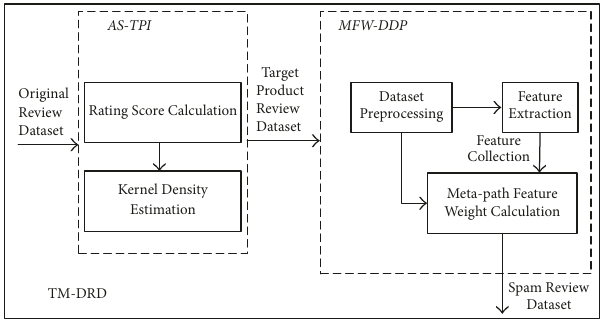
Figure 1: Framework of TM-DRD .